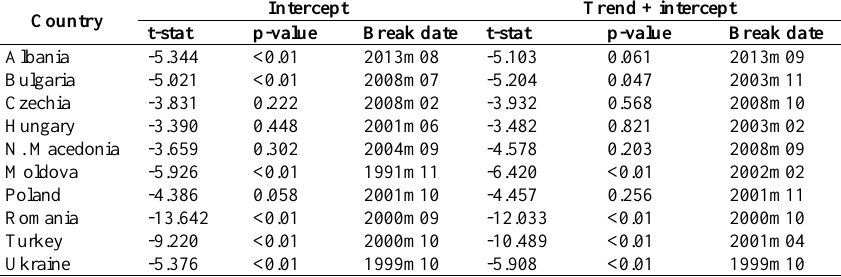
Table 3. Unit root test with an endogenously determined structural break for real